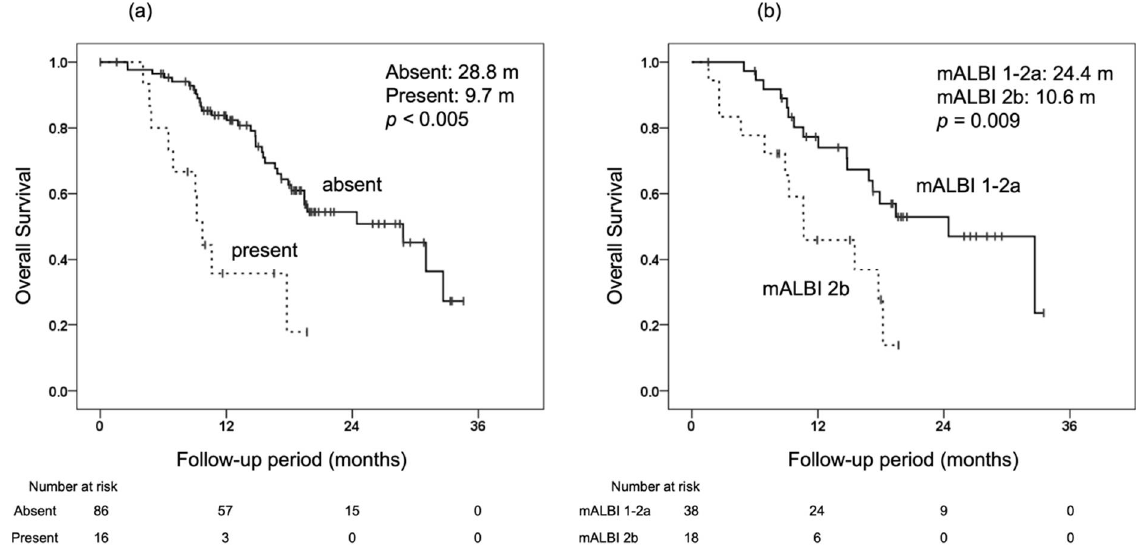
Figure 3. Comparison of overall survival (OS) from the initial objective evaluation of lenvatinib in patients with SD at the initial radiological response evaluation. ( a ) OS from the initial objective eval-